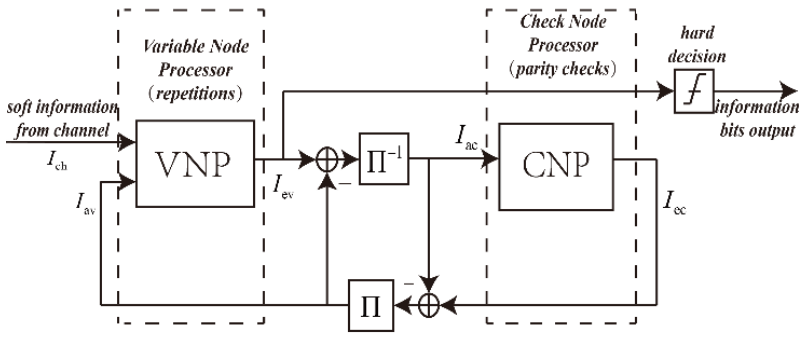
Figure 13. Block diagram of the LDPC decode algorithm.